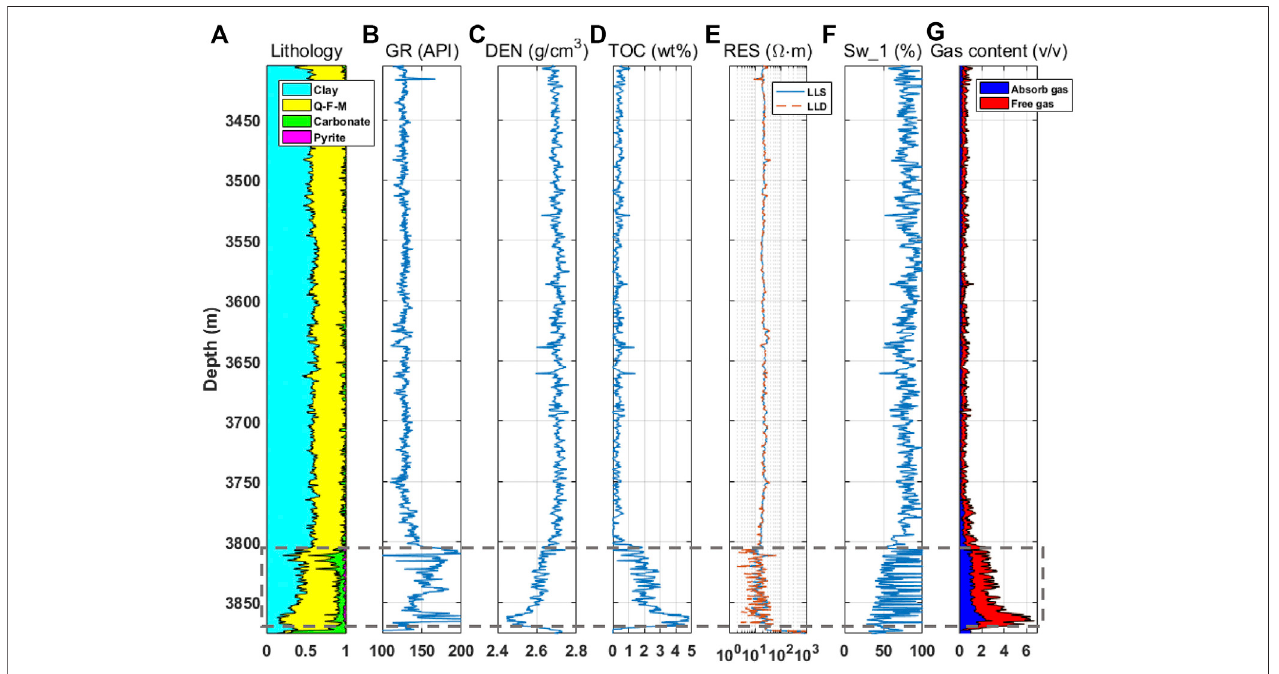
FIGURE 1 | The logging data of Well-Y1 from a shale gas fi eld in Southern Sichuan Basin: (A) mineral components; (B) gamma-ray; (C) density; (D) total organic content (TOC); (E) shallow (LLS) and deep (LLD) resistivities; (F) water saturation evaluated based on resistivity; (G) absorb and free gas contents.